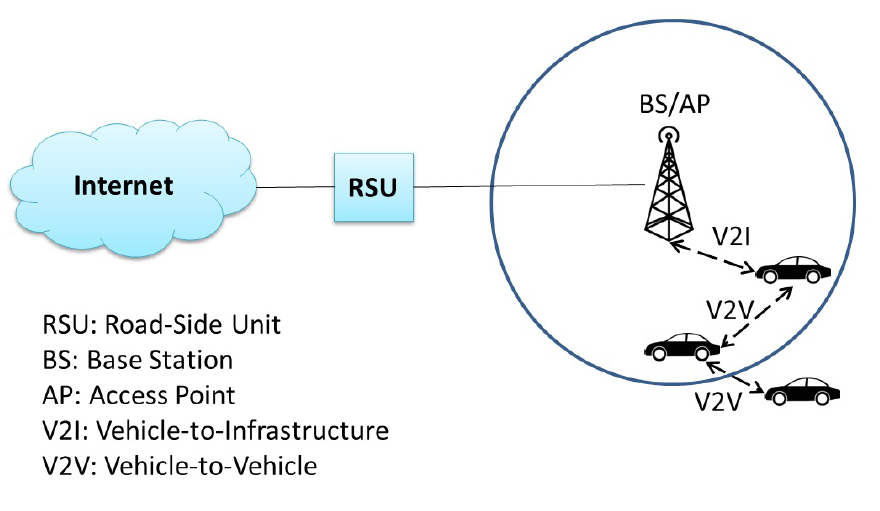
Figure 1. Vehicle-to-vehicle (V2V) and vehicle-to-infrastructure (V2I)